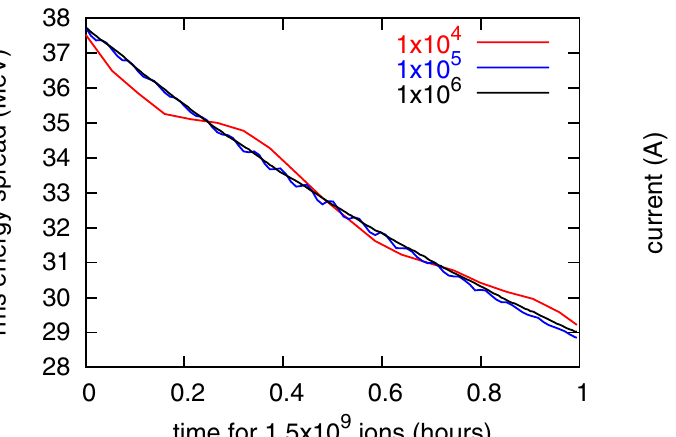
FIG. 10. (Color) Comparison of initial and final wall current monitor data with simulations including rf noise. The red and green lines are the simulated profiles before and after cooling, respectively. The black and blue lines are the experimental data before and after cooling, respectively.